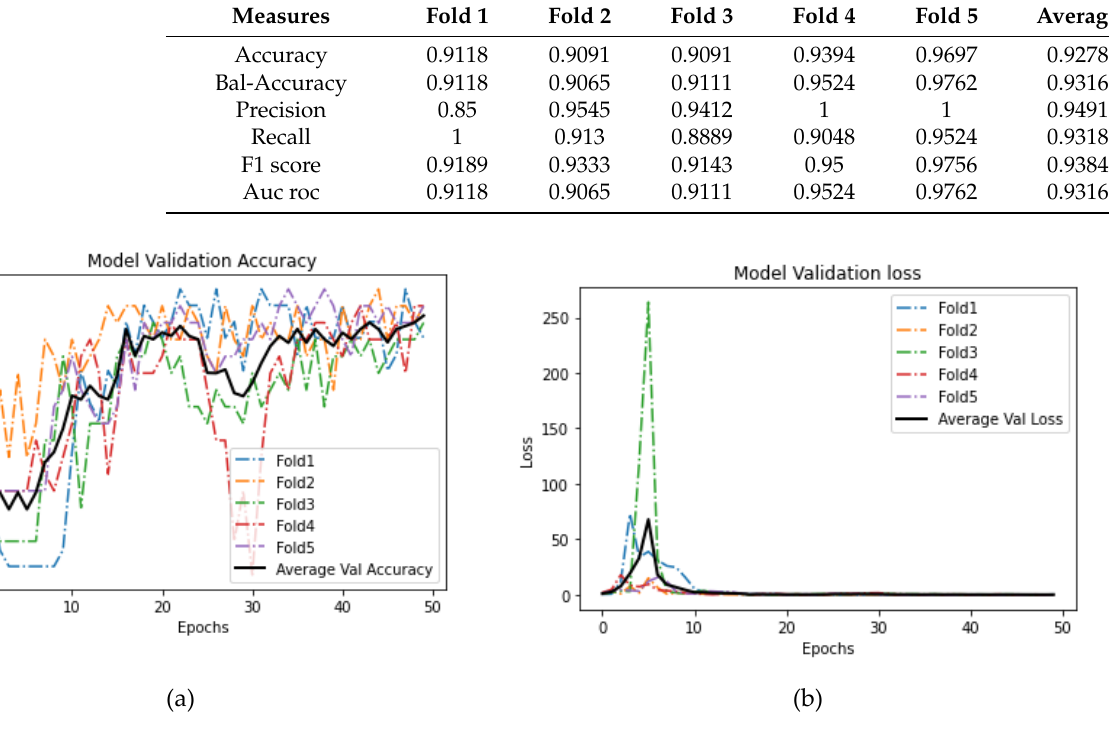
Figure 3. Validation accuracy and loss curve for DenseNet121. ( a ) Model Validation Accuracy; ( b ) Model Validation Loss.